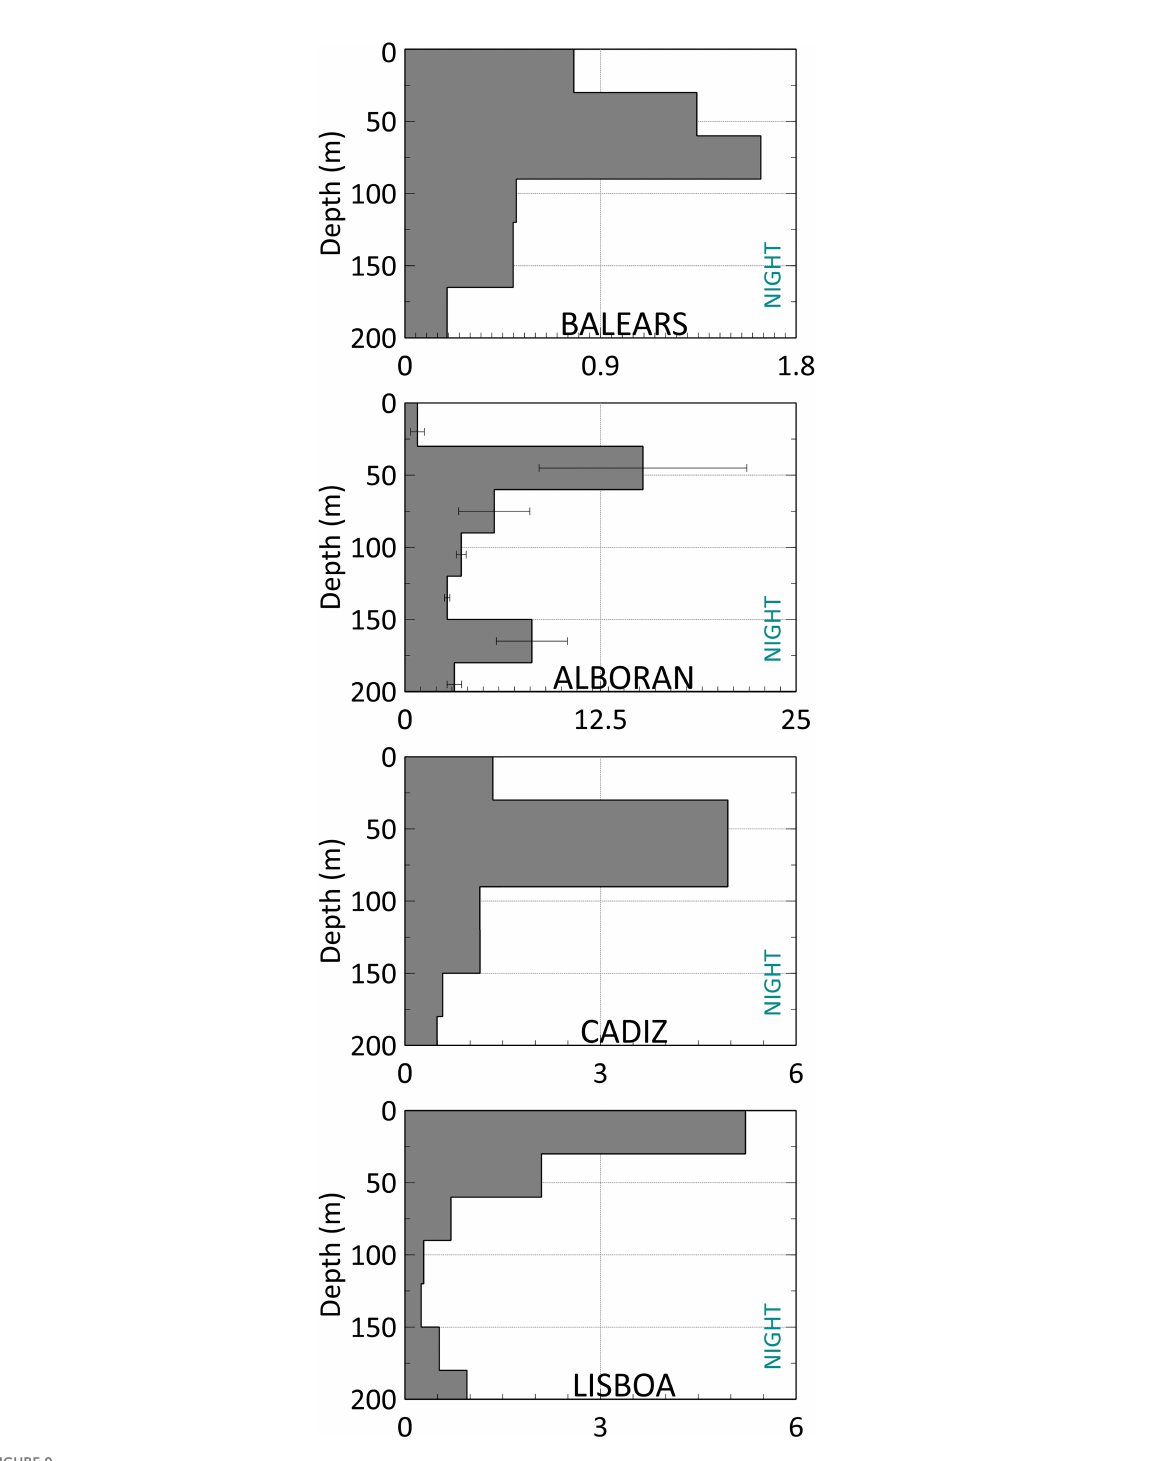
FIGURE 9 Vertical distribution from epipelagic samples performed with the Mesopelagos net every 30 m at night. From top to bottom: St#3 (Balears), St #9 and #10 (Alboran), St#14 (Cadiz) and St#23